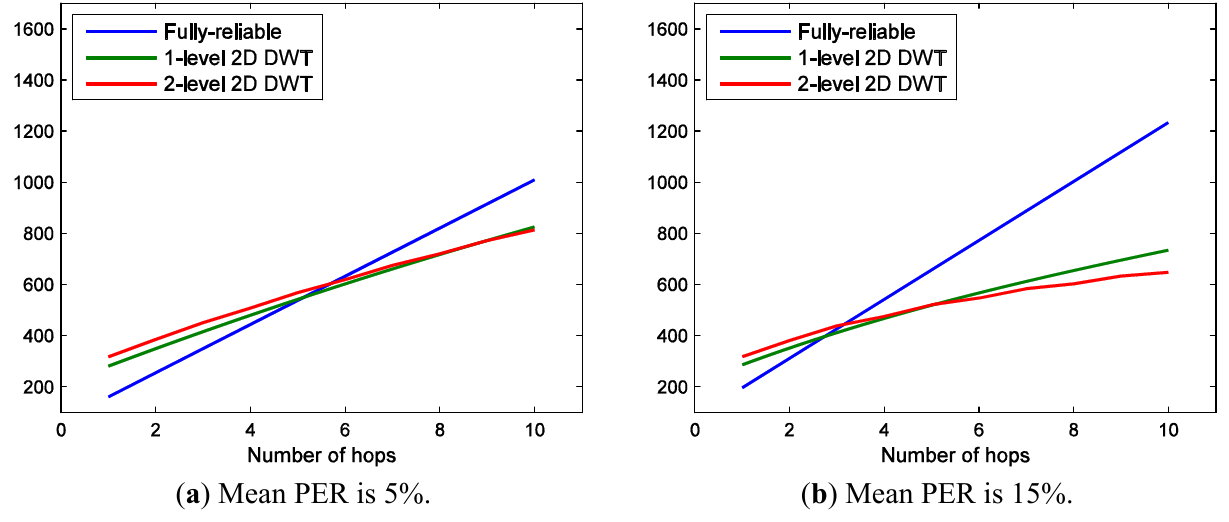
Figure 6. Energy consumption over the